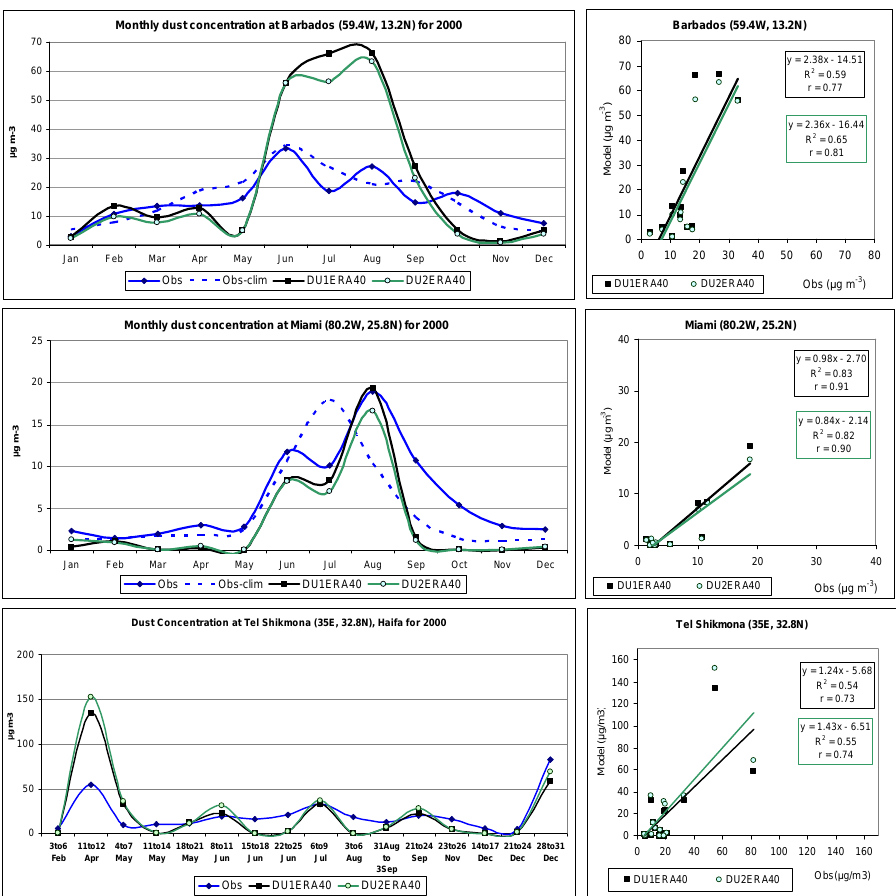
Fig. 8. Comparison of modelled and measured dust concentrations for the year 2000 for stations in Barbados (upper panel), Miami (middle) and Tel Skikmona, Haifa (lower panel). Measurements for the year 2000 are indicated in blue; the multi-annual average concentrations are shown by the blue dotted line. The model results from DU1 ERA40 are shown in black and from DU2 ERA40 in green (nudged simulations). The scatter plots on the right also list the linear regressions and correlation